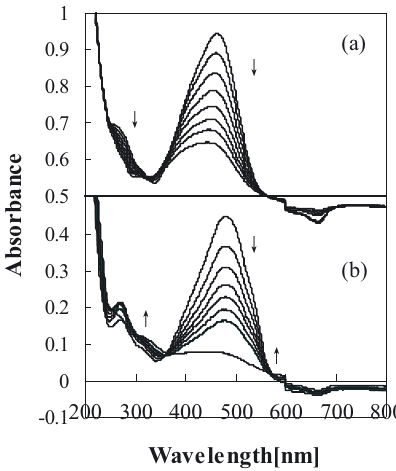
Figure 10. The spectral changes recorded during MO photodegra- dation by H O (a) reaction time of 0, 10, 20, 30, 40, 2 2